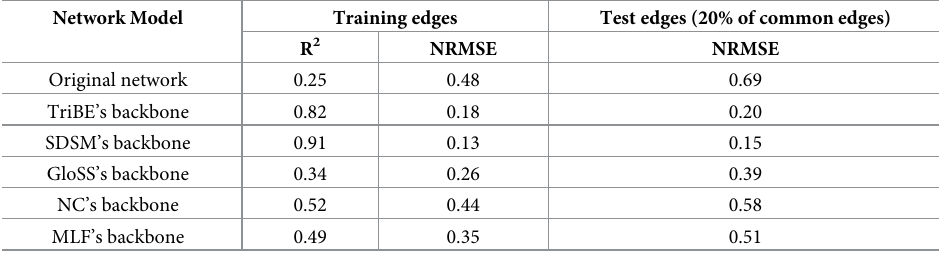
Table 3. Online discussions on Instagram: Contextual evaluation of backbones by regression